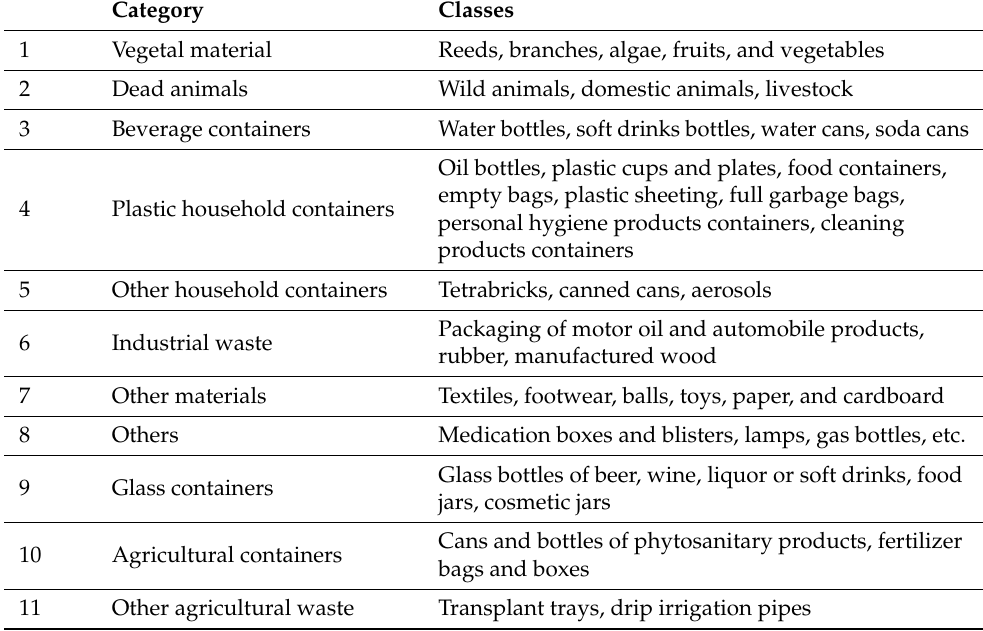
Table 2. Waste categories and